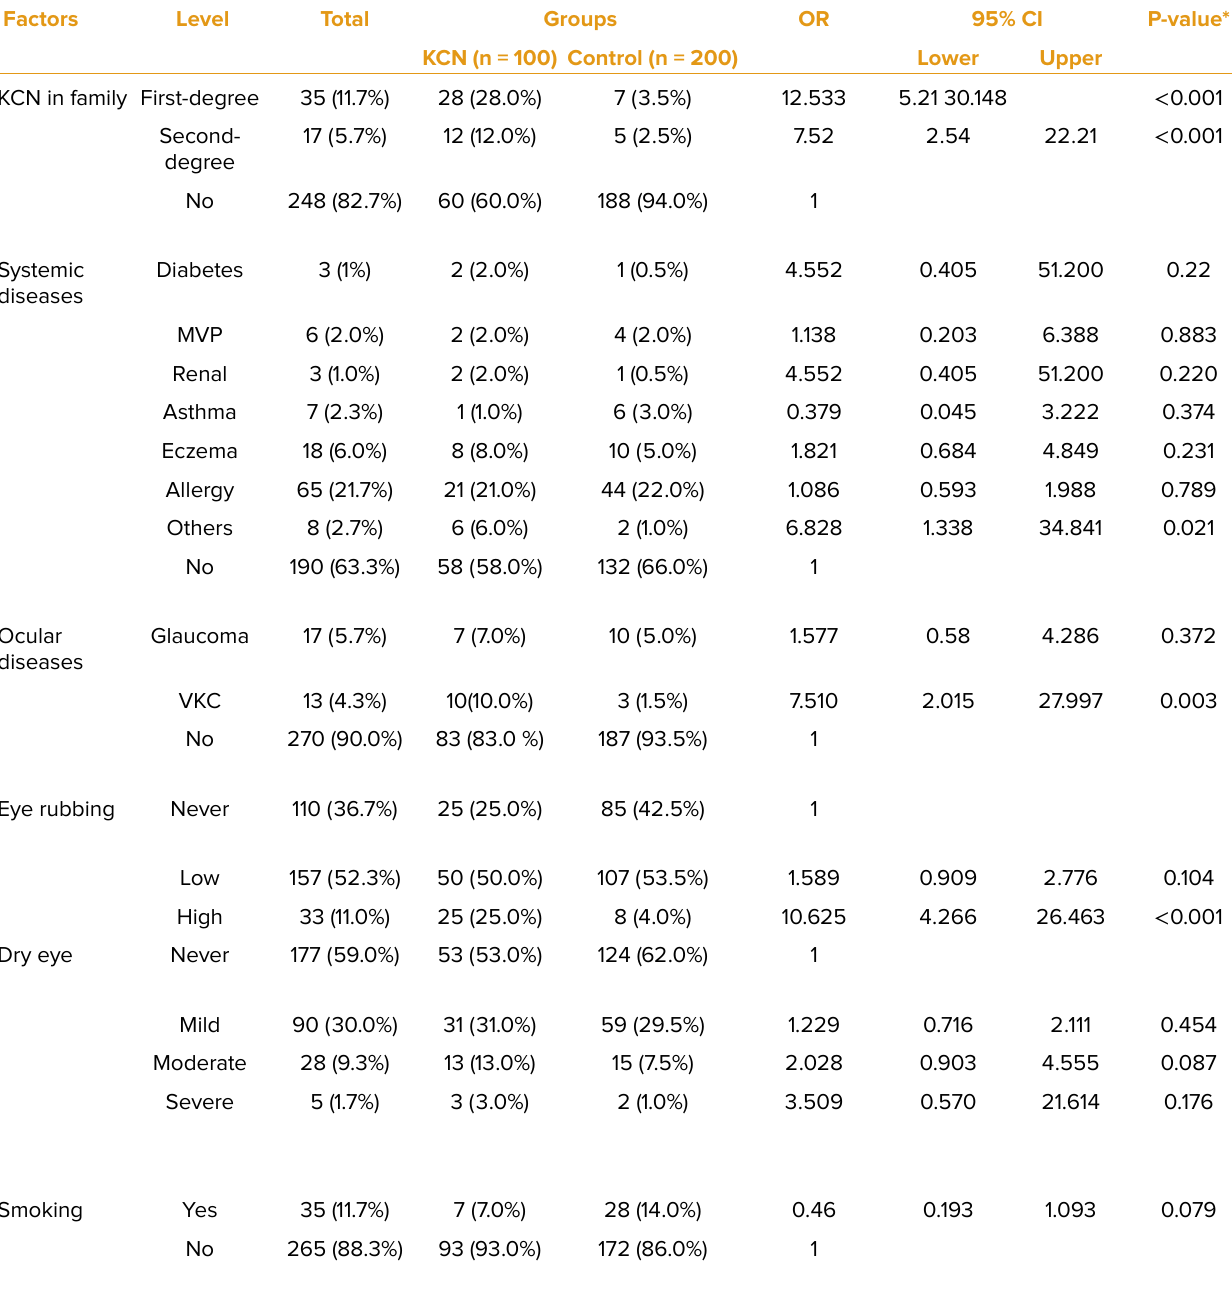
Table 2. Comparison of clinical characteristics between case and control groups to find the probable associated factors.